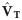
Effects of predicted body weight (gender neutral height) on standardized tidal volume (V^T) and ARDS documentation in ARDS and control cohorts.Top panels show patients with ARDS documented in their chart (purple diamonds) and non-documented patients (tan circles). Gray areas represent LTVV range from current guidelines[7], with dashed line at 6.5 mL/kg PBW at current recommended threshold. Solid lines show linear (V^T) and logistic (documentation) fits for scatter plot data (shaded regions, 95% confidence bands). Reported beta coefficients are for standardized inputs. * p < 0.0003.